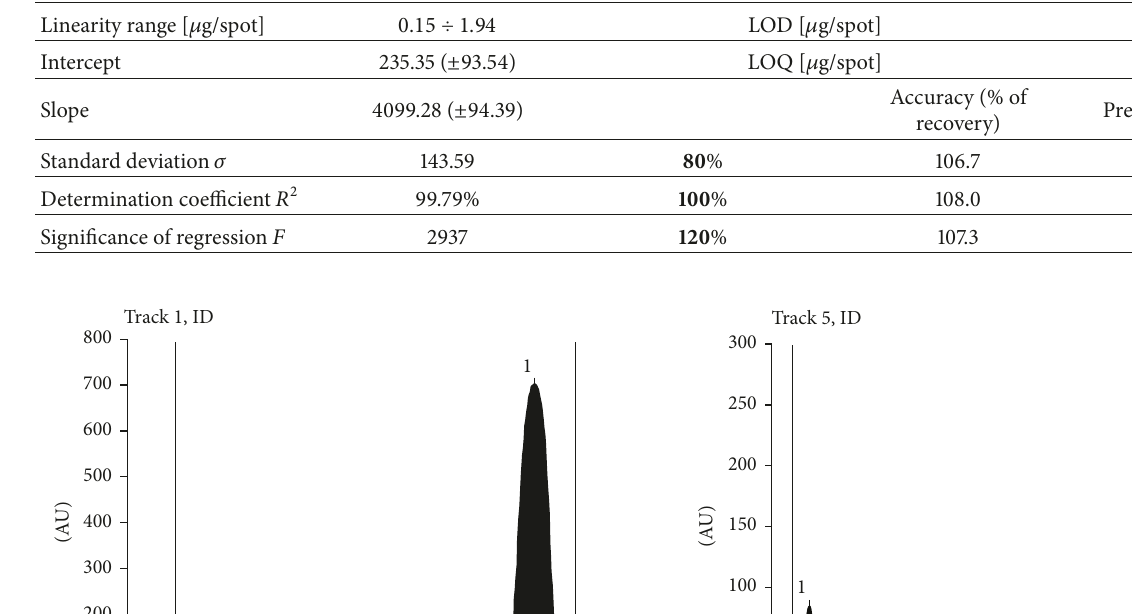
Table 1: Validation parameters describing the diphenhydramine analysis method.